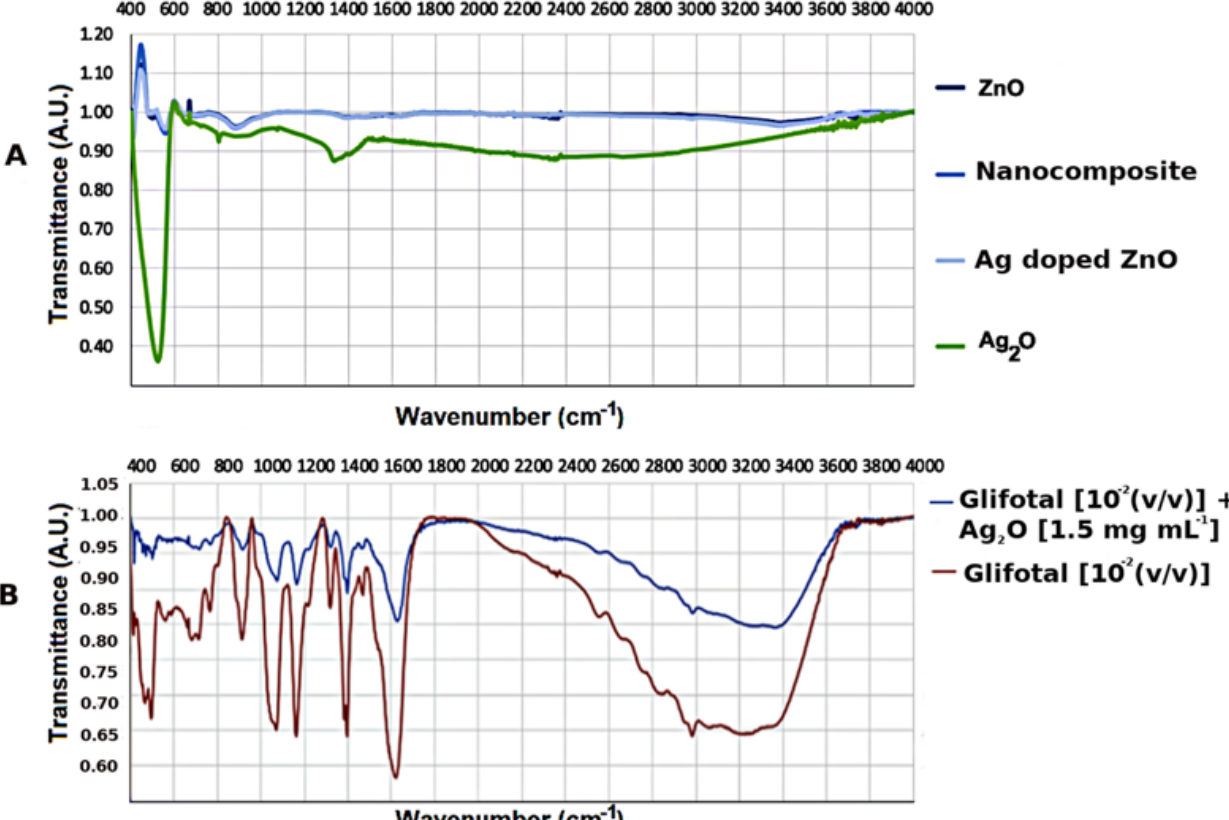
Figure 2. ( A ) Fourier transform infrared spectroscopy (FTIR) spectra of ZnO nanocrystals (NCs), Ag-doped ZnO, nanocomposite, and Ag 2 O NCs. ( B ) FTIR spectra of commercial formulation of glyphosate (GLIFOTAL TR ) and GLIFOTAL TR Ag 2 O NCs at 10 − 2 ( v / v ).